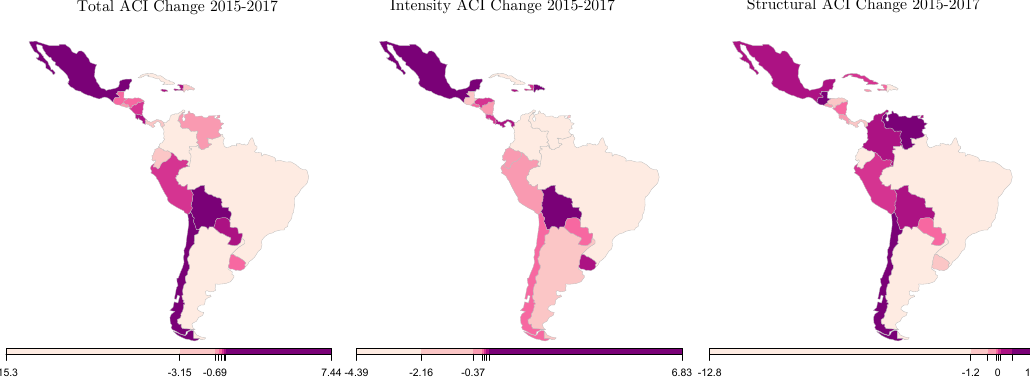
Figure 7. LMDI analysis applied to CO 2 emissions by country, period